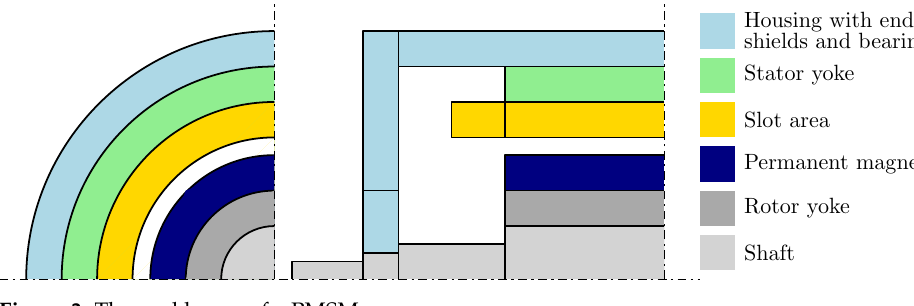
Figure 3. Thermal layers of a PMSM.